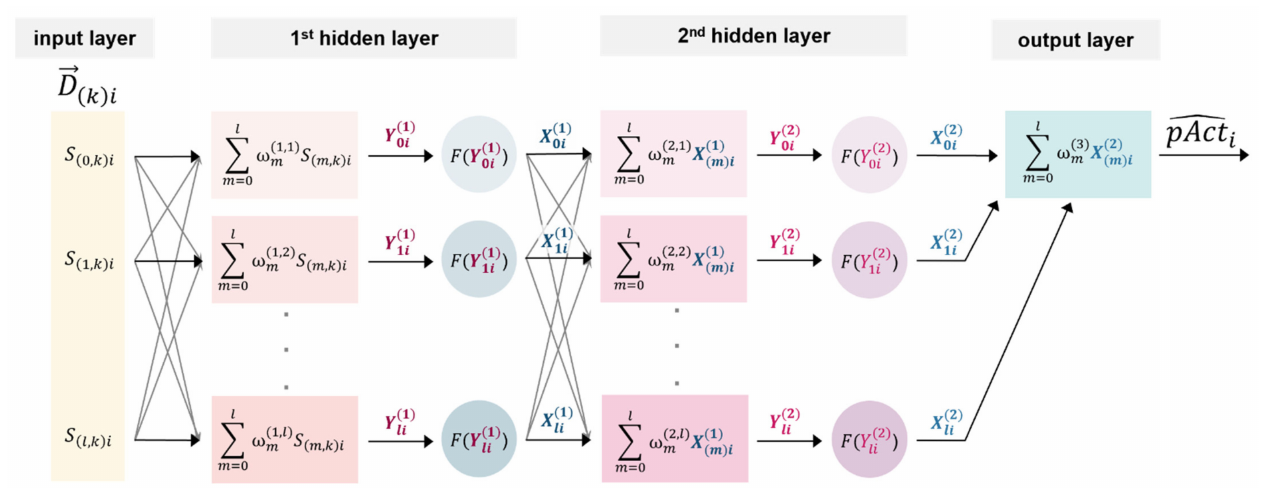
Figure 3. Schematic representation of the multilayer perceptron (MLP) neural network architecture (with two hidden layers) utilizing the VLA-featured binary SMILES input